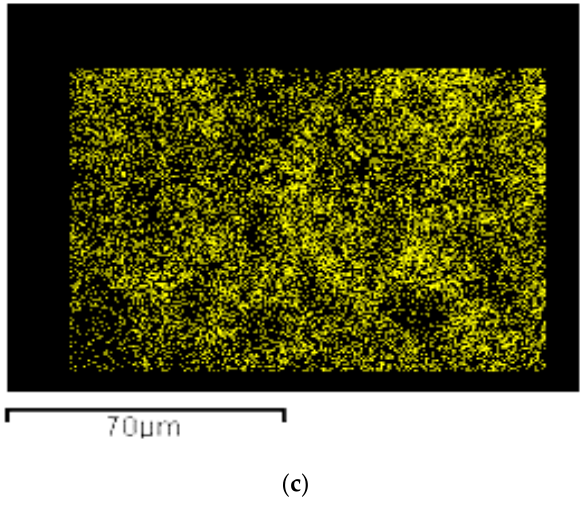
Figure 3. EDX Ti elemental mapping related to 15PVDF-coHFP_10TiO 2 ( a ), 15PVDF-coHFP_20TiO 2 ( b ), and 15PVDF-coHFP_30TiO 2 ( c ).